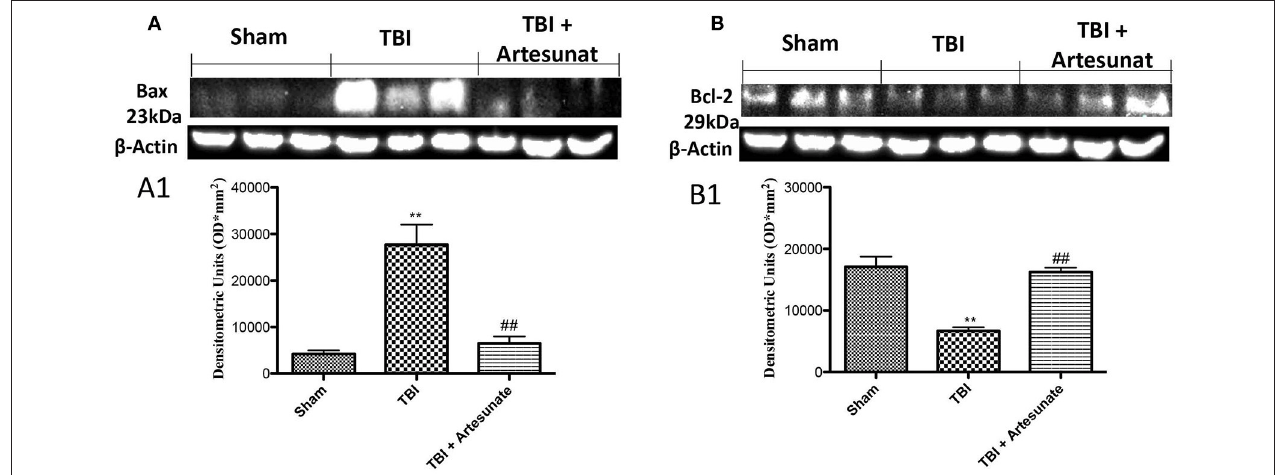
FIGURE 5 | Protective effect of artesunate treatment on apoptosis process. (A) Western blot analysis for Bax showed that 24h after TBI injury, brain from vehicle group showed a significant increase in Bax expression compared to sham group, instead brain from mice that have been treated with artesunate showed a significant reduction in Bax expression compared to vehicle group, see densitometric analysis (A1) . (B) Showed a basal expression of Bcl-2 in brain homogenates from sham mice, after TBI injury the vehicle group showed a significant reduction in Bcl-2 expressions. Treatment with artesunate was able to prevent the reduction in Bcl-2 expression and reports the levels similar to the sham group, see densitometric analysis (B1) . Data are expressed as Mean ± SEM from N = 10 Mice for each group ** P < 0.01 vs. respective sham; ## P < 0.01 vs. respective TBI. ( F -value for Bax = 22.93. df = 2. r 2 = 0.8843) ( F -value for Bcl-2 = 27.64. df = 2. r 2 = 0.9021) (see the Supplementary Figures 6, 7 for the triplicate of western